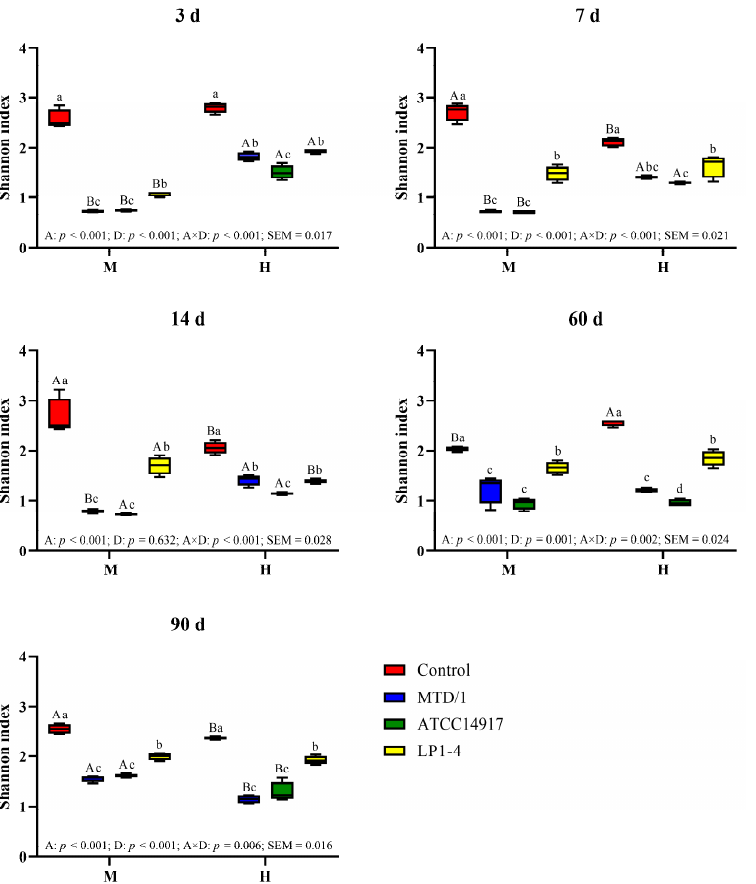
Figure 1. Variations in community alpha-diversities (Shannon index) of alfalfa silage during ensiling. Control, distilled water; MTD/1, MTD/1 treatment; ATCC 14917, ATCC14917 treatment; and LP1-4, LP1-4 treatment. M, moderate dry matter; H, high dry matter. Different lowercase letters indicate significant differences in treatments ( p < 0.05). Different uppercase letters indicate significant differences in dry matters ( p < 0.05).